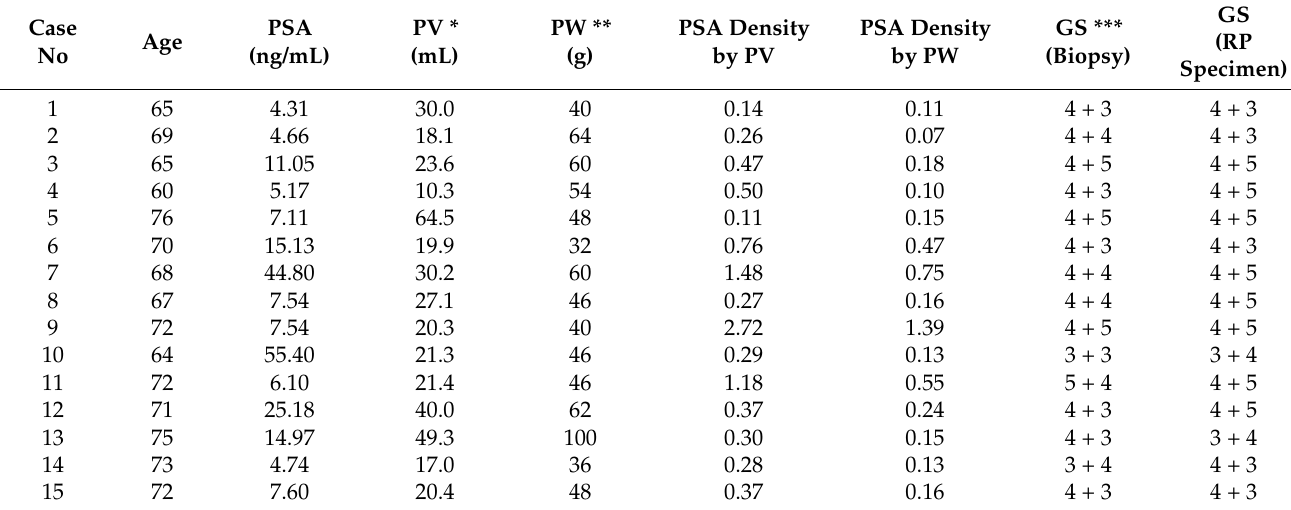
Table 2. Baseline characteristics of each